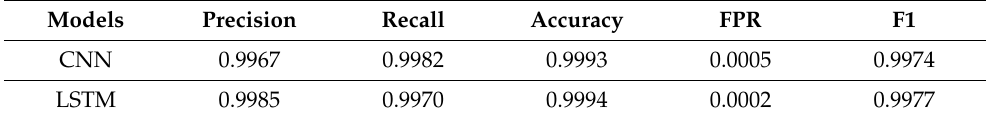
Table 3. Results obtained with LSTM and CNN models with a split of 80% training and 20% testing.